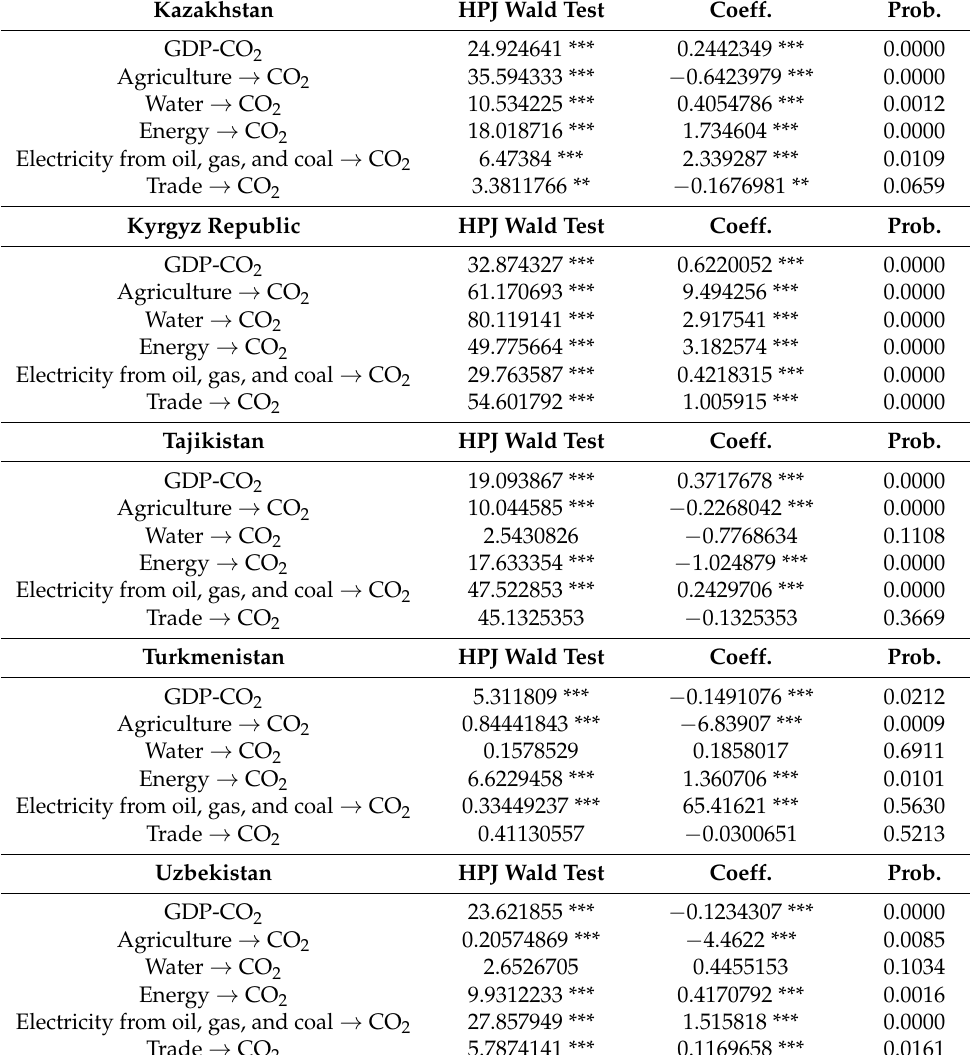
Table 9. Juodis, Karavias and Sarafidis (2021) Granger non-causality test results by